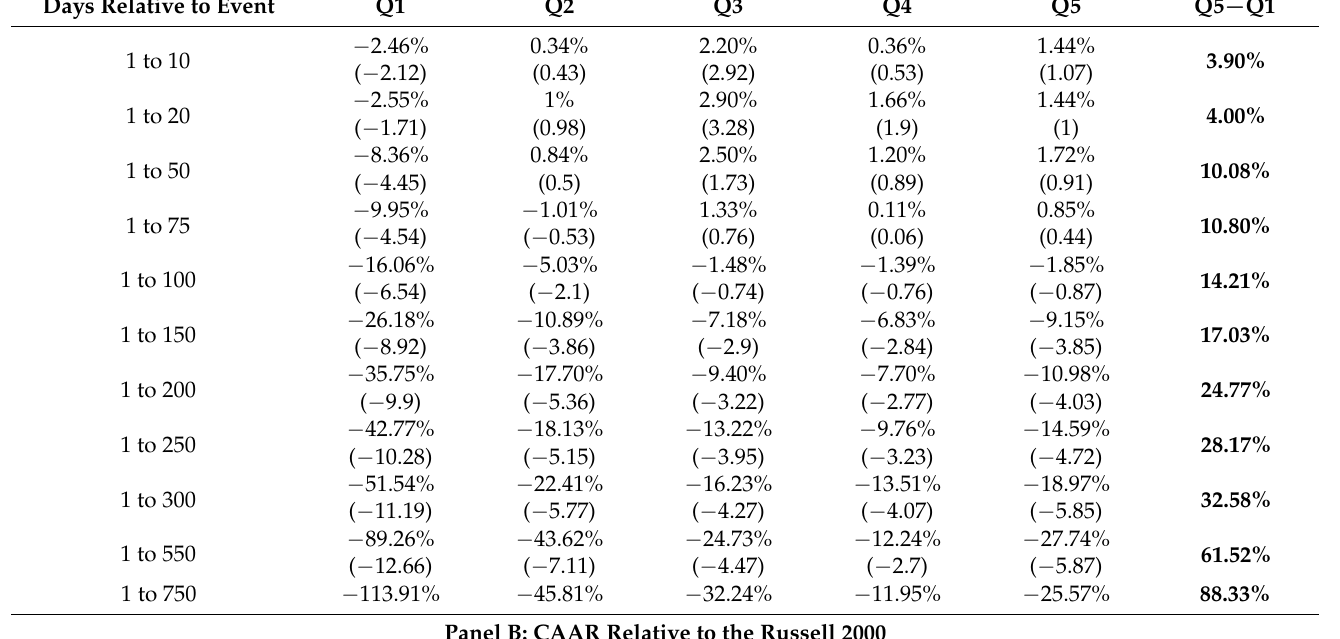
Table 2. Size (MV before the IPO)-Ranked Portfolios and the Performance of IPOs. Panel A: CAAR Relative to the S&P